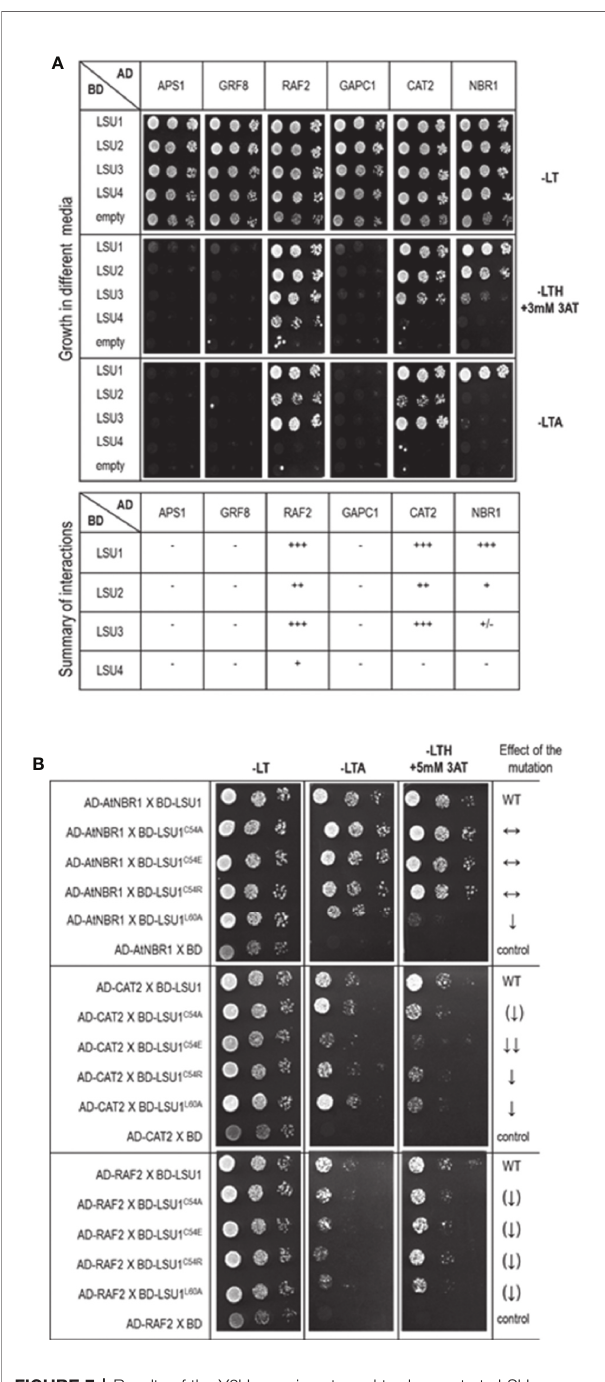
FIGURE 7 | Results of the Y2H experiment used to demonstrate LSU interaction with other proteins (A) and effect of the LSU1 mutations on these interaction (B) . For (A) a summary of interactions is shown below the images, illustrating yeast growth of 10-fold serial dilutions of cultures on different selection media For (B) the effect of the mutations on protein interaction is indicated on the right; WT, interaction with wild type LSU1 (used as a respective reference), ↔ , no effect of the mutation on interaction; ↓ , reduced binding; ↓↓ , strongly reduced binding; ↑↑ , strongly increased binding; the ( ↑ ) and ( ↓ ) mark the very weak effects - a tendency towards increase and decrease of binding, respectively.. The plates were incubated for three days at